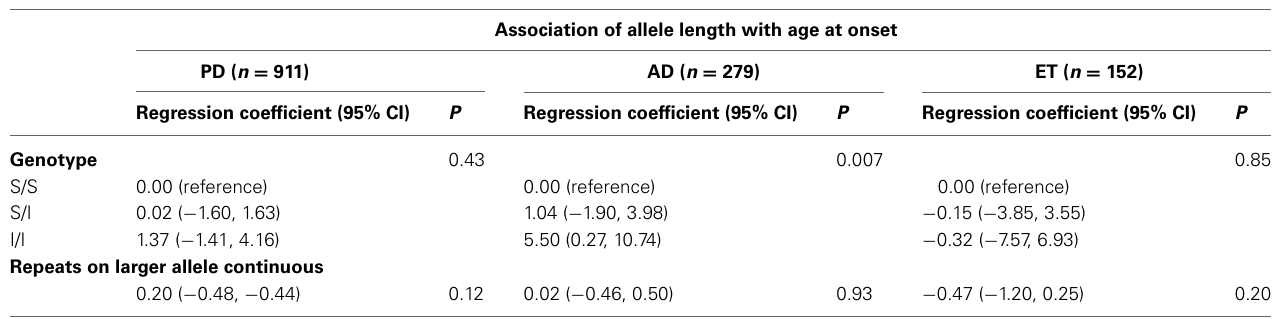
Table 3 | Association of allele length with age at onset in patients with PD, AD, and ET.